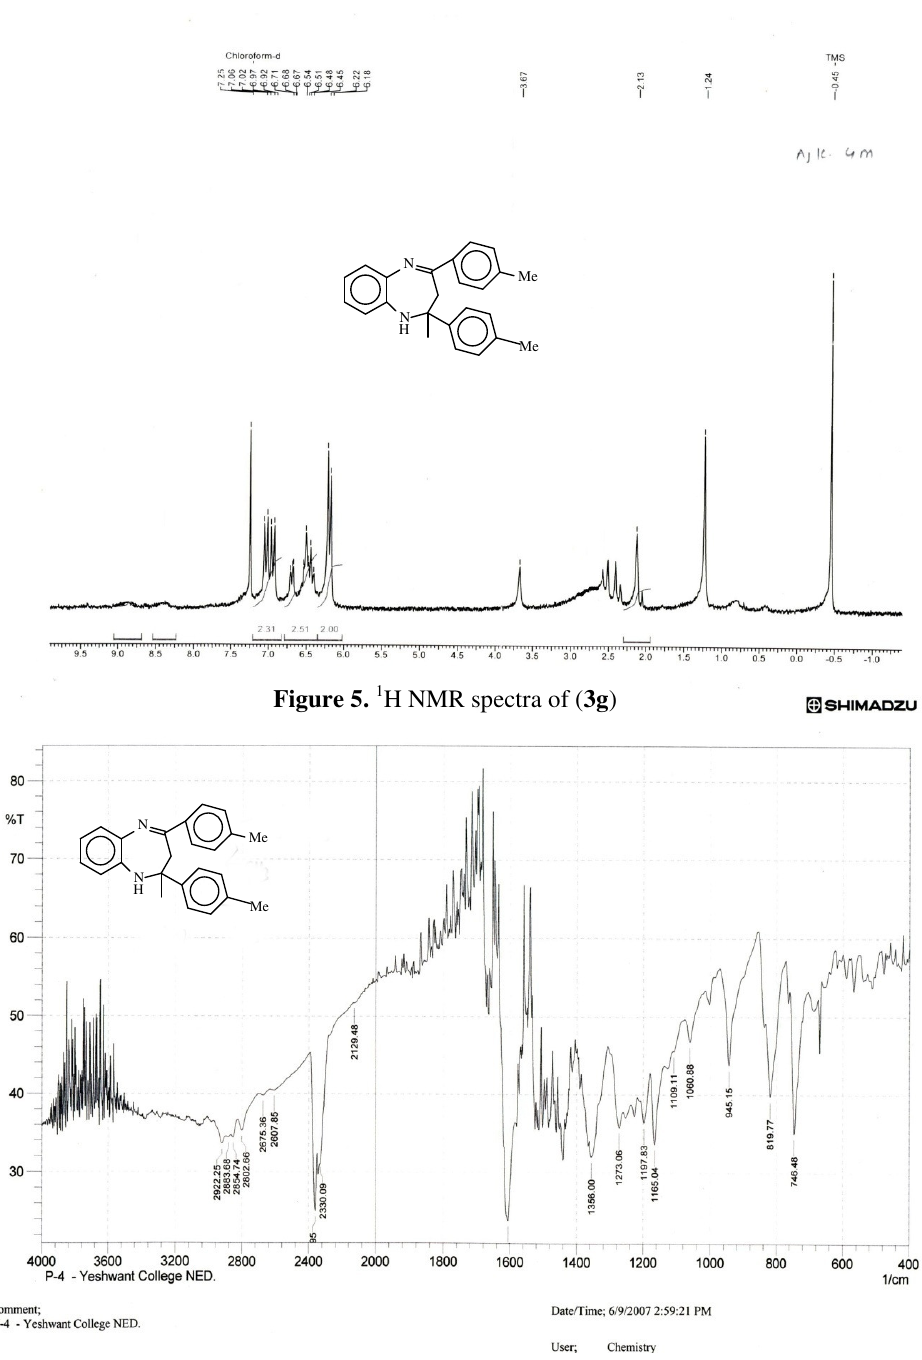
Figure 6. IR spectra of (